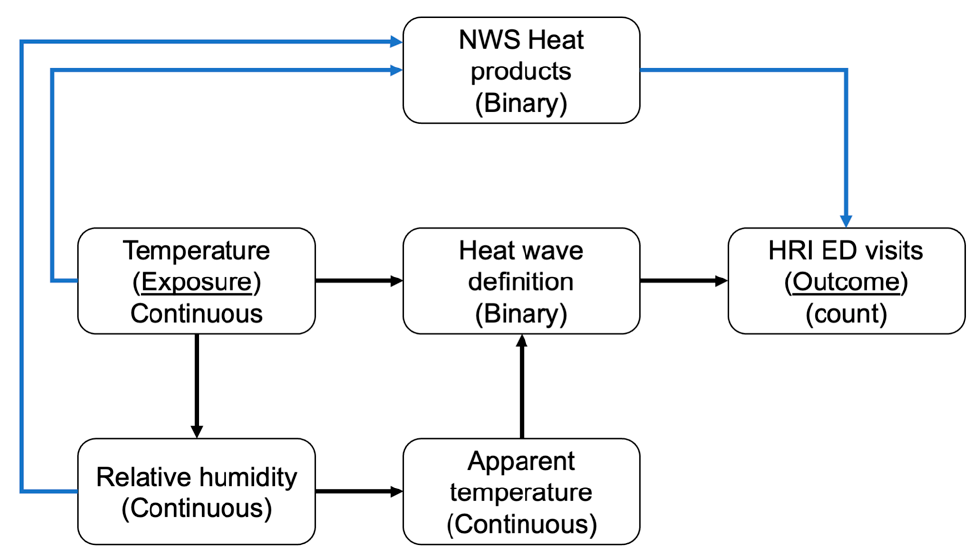
Figure 1. Conceptualization of evaluating the direct effect of temperature or apparent temperature on HRI ED visits. We assumed that the association between temperature and HRI is mediated through NWS heat products. Additionally, relative humidity is influenced by temperature. To evaluate the association between HWDs based on temperature and HRI, we adjusted for relative humidity and NWS heat products. We adjusted for NWS heat products while evaluating the association between HWDs based on apparent temperature and HRI ED visits.